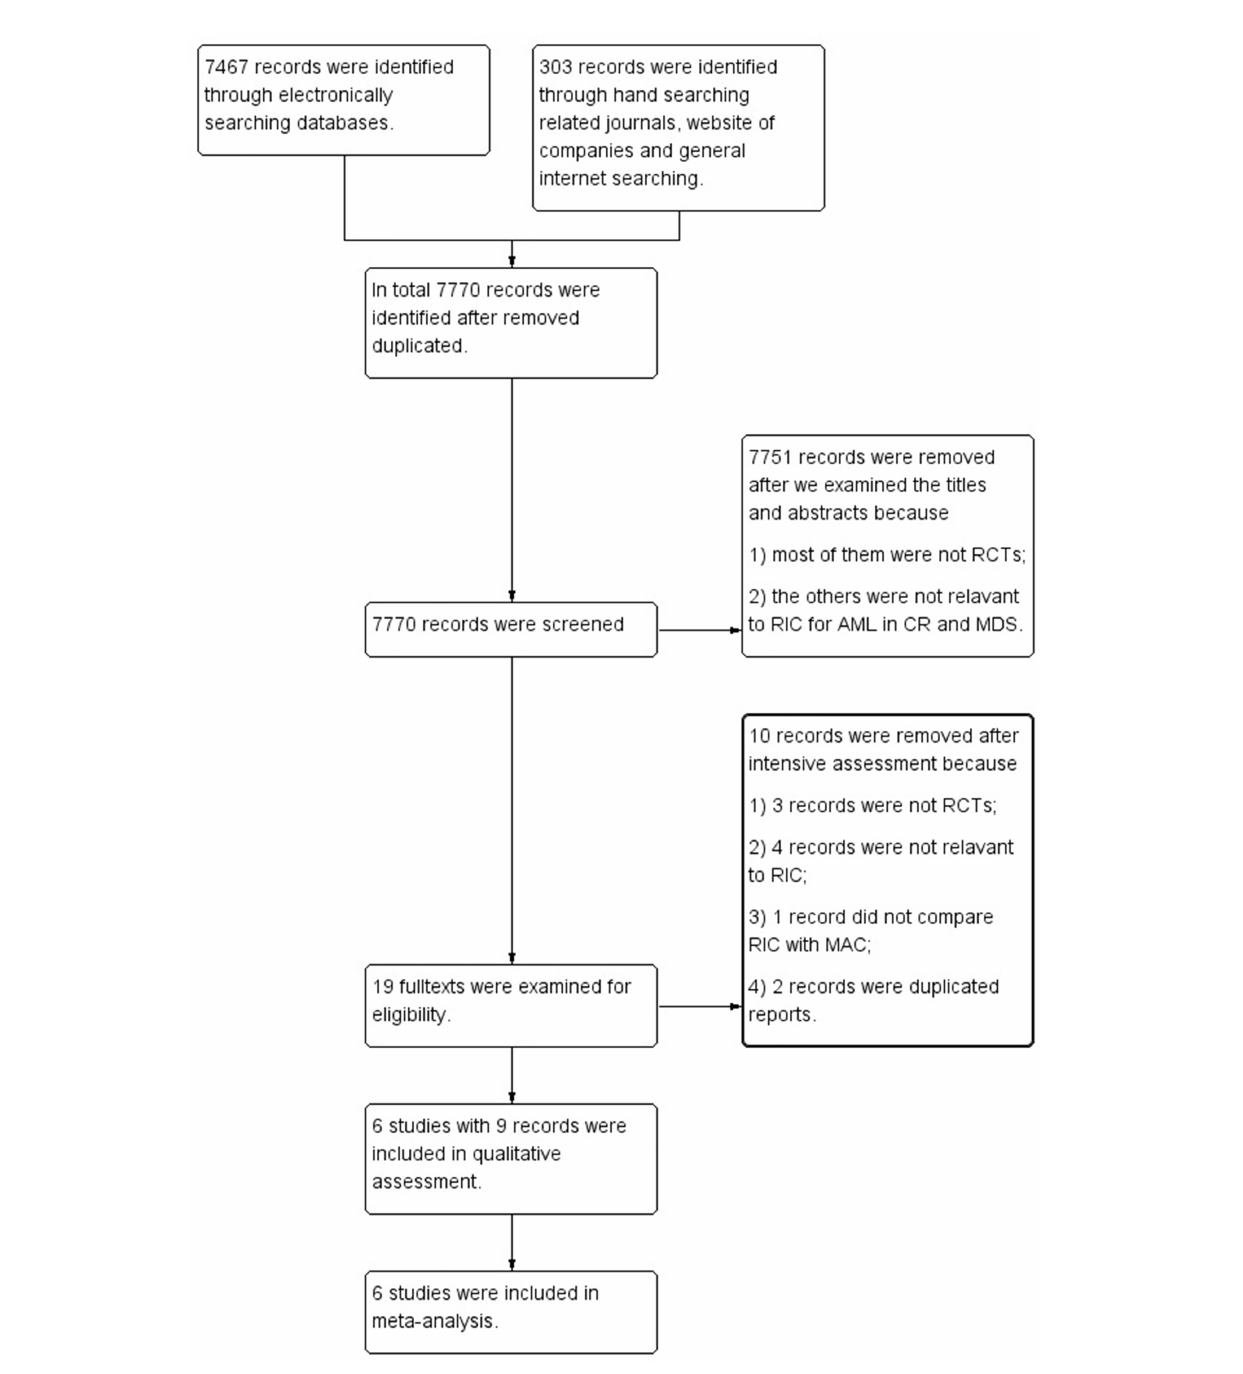
FIGURE 1 | Flow diagram of screening studies for inclusion in systematic review. AML, acute myeloid leukemia; CR, complete remission; MDS, myelodysplastic syndrome; RCTs, randomized controlled trials; RIC, reduced intensity conditioning; MAC, myeloablative